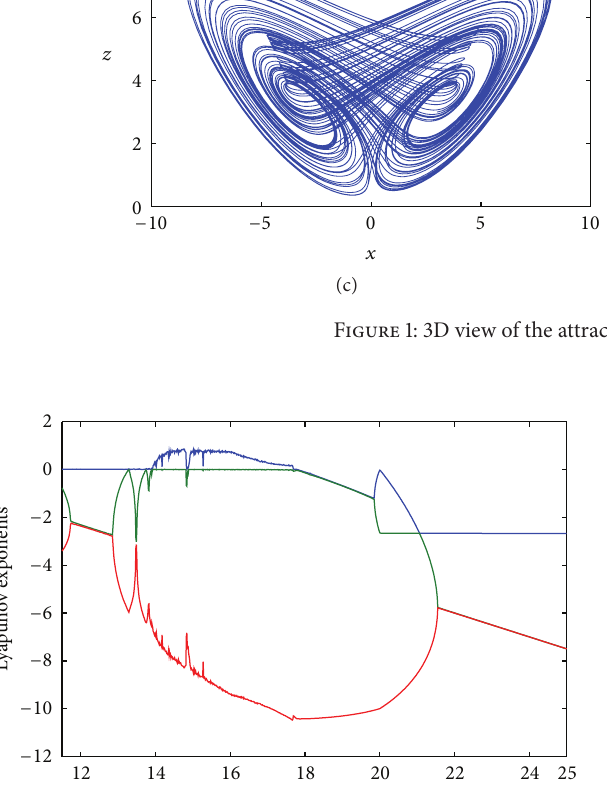
Figure 3: Bifurcation diagram of the system with respect to 𝑎